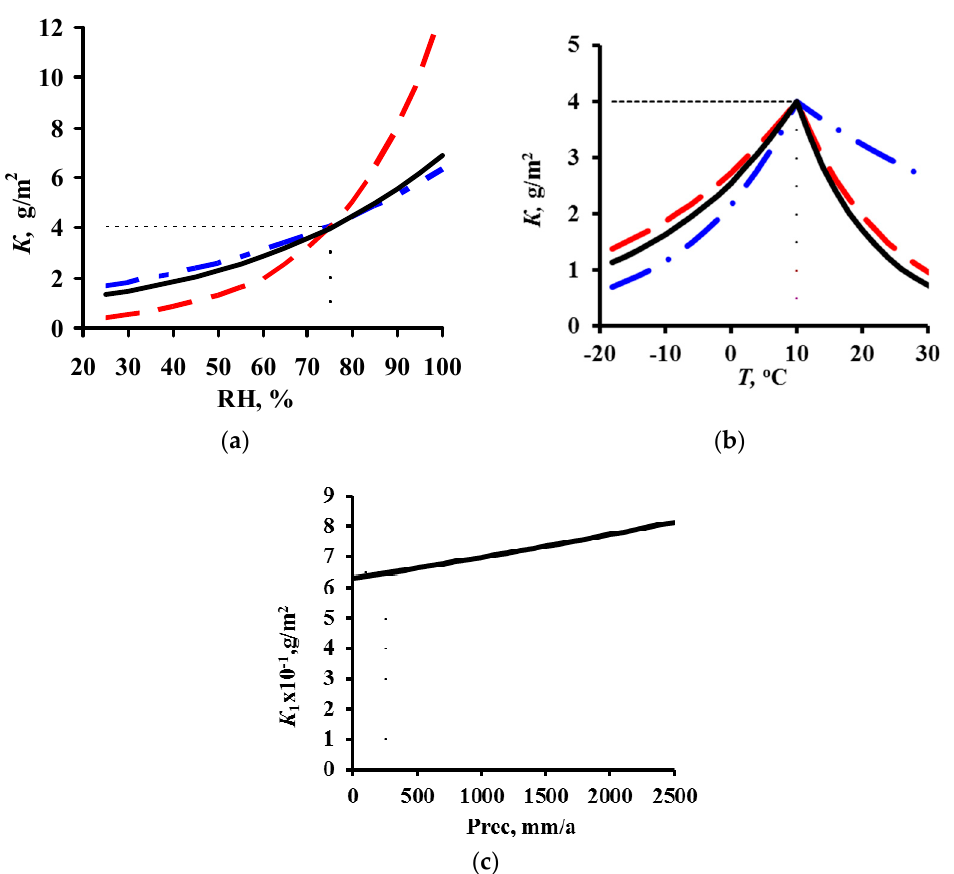
Figure 11. Variation of K for zinc versus relative humidity ( a ), temperature ( b ) and Prec ( c ) with account for the values of the DRF coefficients. ▬▬ by the New DRF; ▬ ▬ by the Standard DRF; ▬ • ▬ by the Unified DRF.